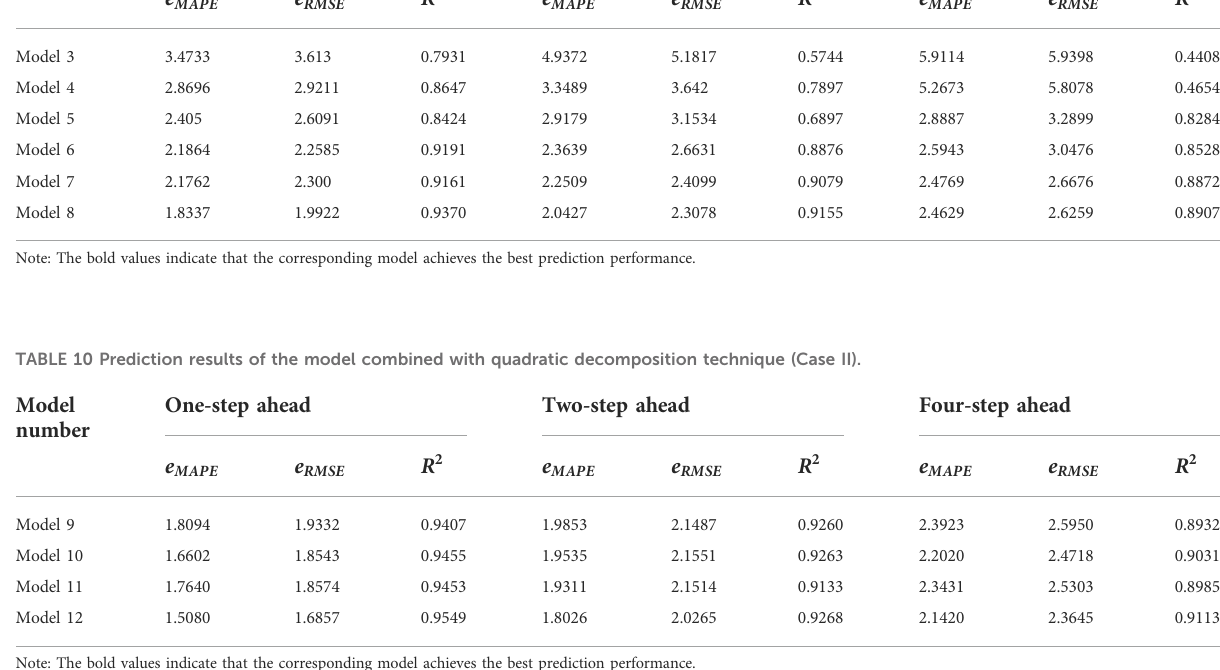
TABLE 9 Prediction results of the model combined with single decomposition technique (Case II). Model number